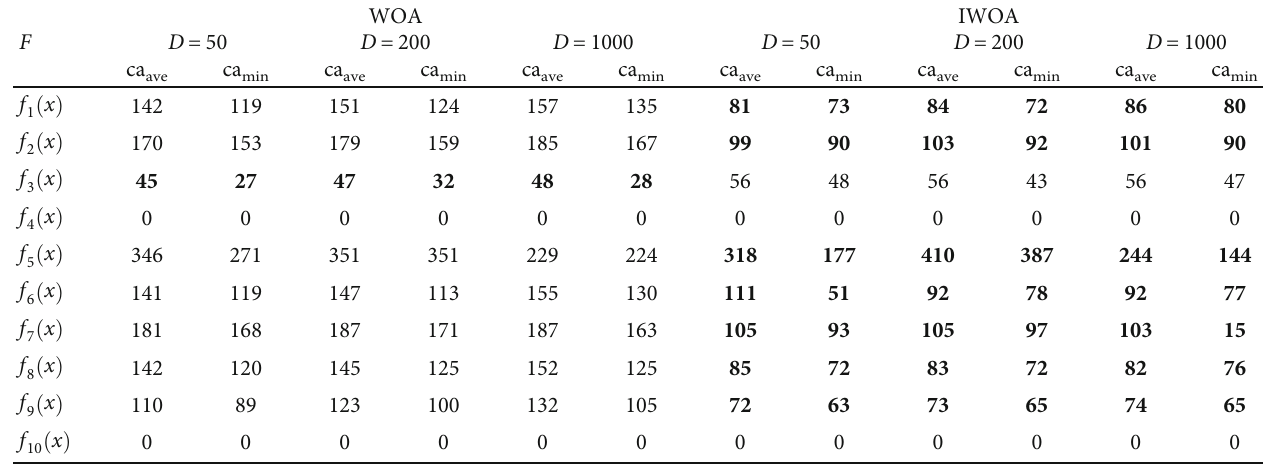
Table 8: Comparison of convergence algebra of two